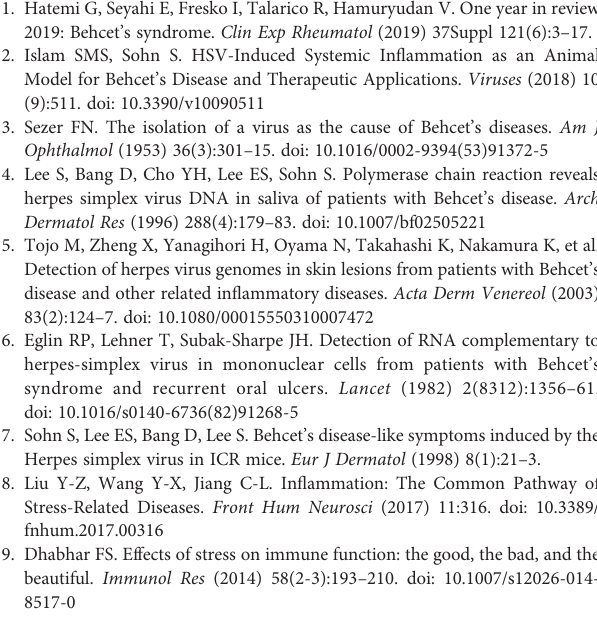
Supplementary Figure 2 | Substance P (SP) for anxiety stress increased frequencies of DC co-stimulatory molecules CD40 and CD83 in peripheral blood leukocytes (PBLs) of normal mice. Isolated PBLs were analyzed by fl ow cytometry after surface staining (A – D) . For statistical analysis, one-way ANOVA was performed using GraphPad. Experiments were conducted independently at least three times.